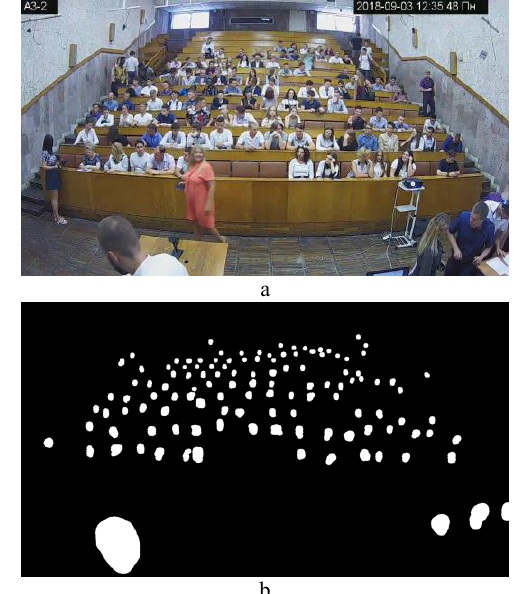
Figure 2. Example of source image and mask from dataset: a –